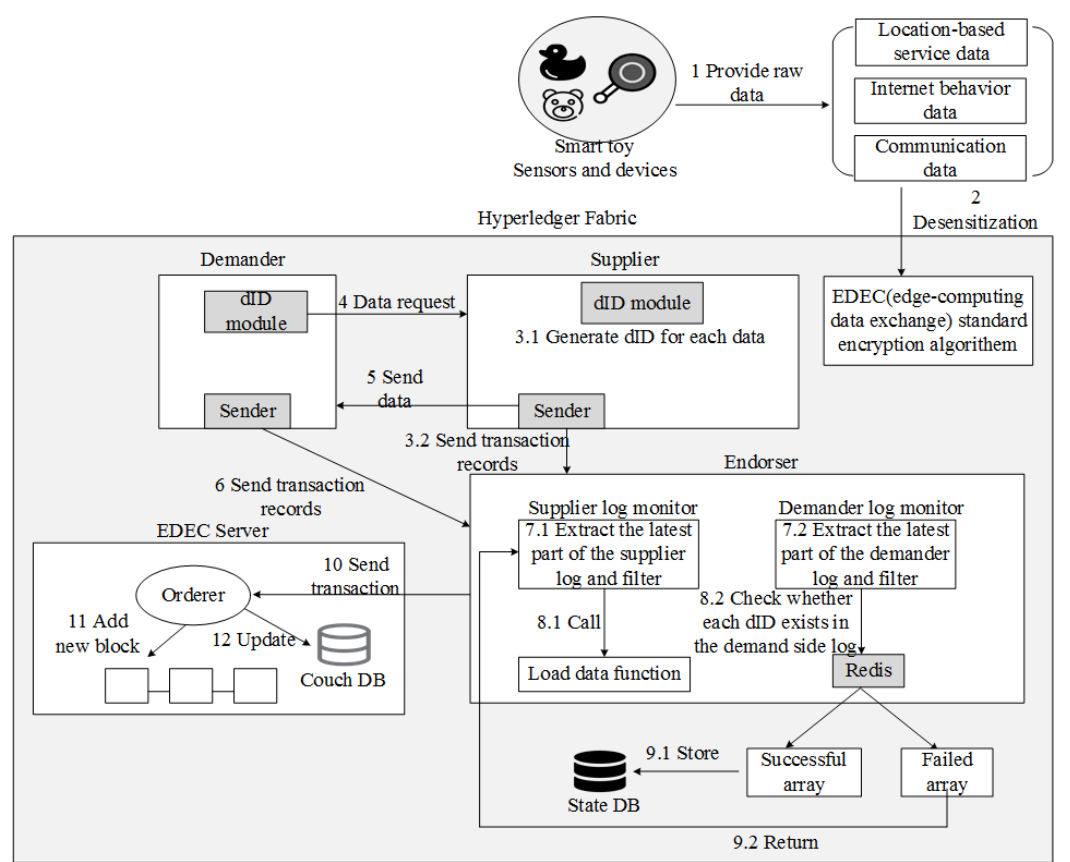
Figure 21. Reconstruction diagram of reference [47].